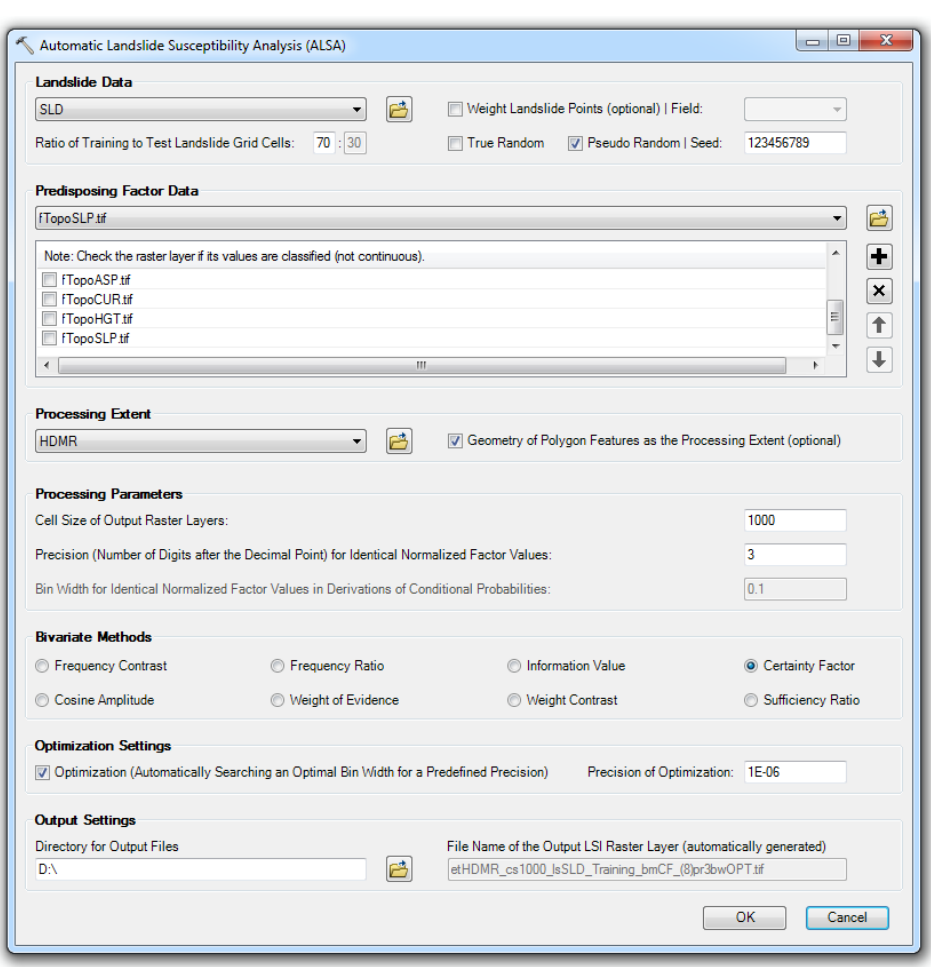
Figure 4. Interface of ALSA (Automatic Landslide Susceptibility Analysis) 3.0.